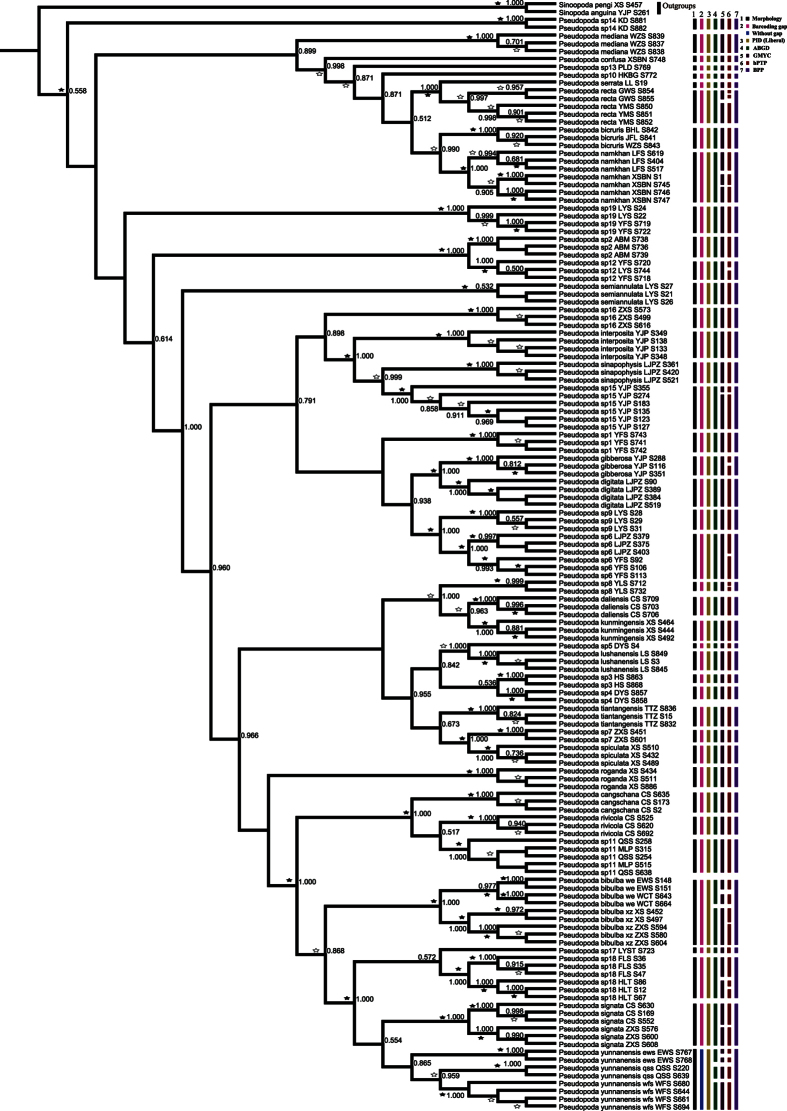
Bayesian tree based on the COI + ITS2 dataset including 140 individuals, with the results of six different species delimitation approaches in addition to morphology (see legend).Blue bar indicates barcoding overlap for focal species. Numbers on nodes are posterior probabilities; bootstrap support from ML analyses is indicated as solid stars for values >95%, open stars >50–95%.